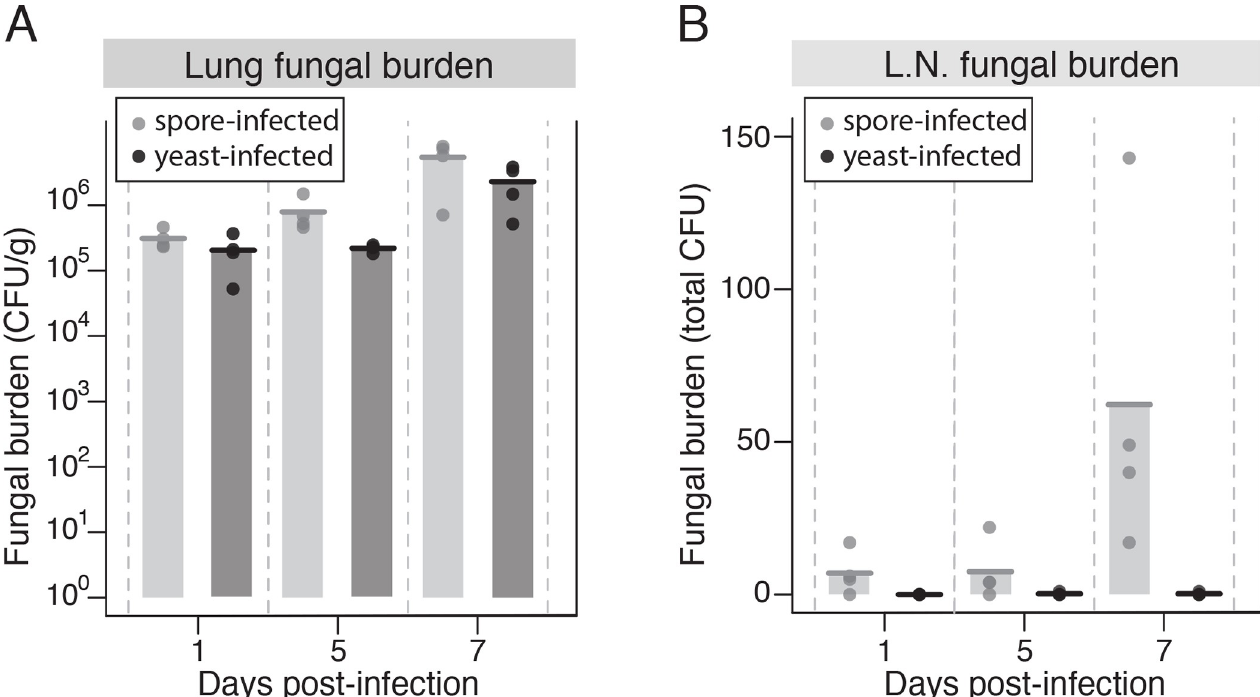
Fig 4. Cryptococcus disseminates to the draining lymph node very early in spore-mediated infections. (A) Fungal burden (colony forming units per gram of tissue) in the lungs of mice (3 per group) infected intranasally with 1x10 6 yeast in a 1:1 mixture of JEC20 +J EC21 (dark gray) or 1x10 6 spores derived from a JEC20 x JEC21 cross (light gray) after 1, 5, and 7 days of infection. (B) Fungal burden (total colony forming units per organ) in the lymph nodes of mice infected intranasally with 1x10 6 yeast in a 1:1 mixture of JEC20 + JEC21 (dark gray) or 1x10 6 spores derived from a JEC20 x JEC21 cross (light gray) after 1, 5, and 7 days of infection. Data are representative of multiple biological replicates (see S6